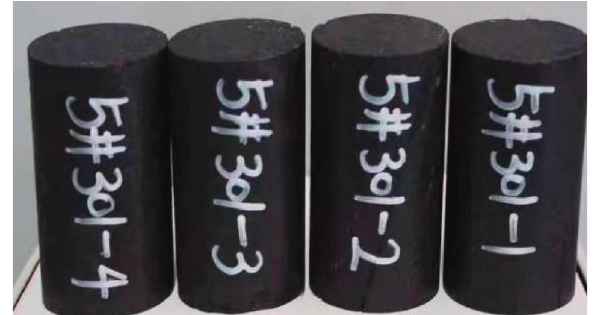
Figure 2: Experimental coal samples.